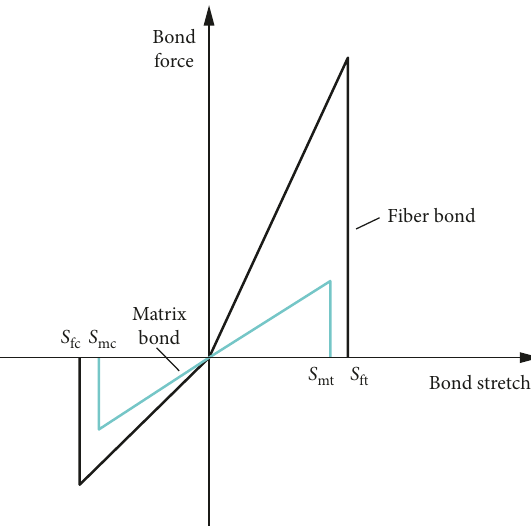
Figure 2: Constitutive model of composite lamina.